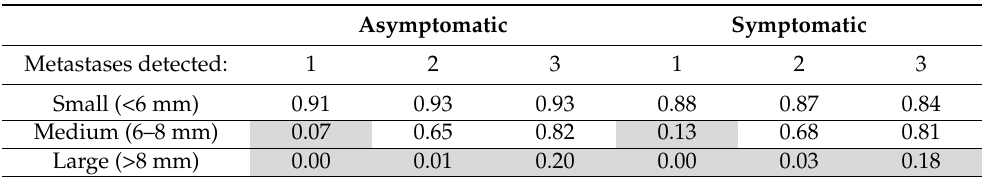
Proportions of oligo+ per risk sub-group. Grey fields represent the low-risk